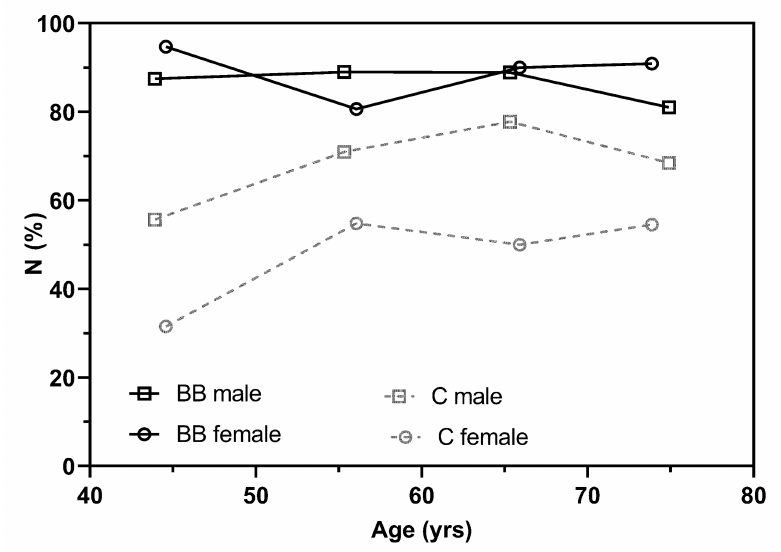
Figure 2. Age related percentage of non-regular HRPCs in male and female individuals with (BB) and without (C) β -blocker treatment.